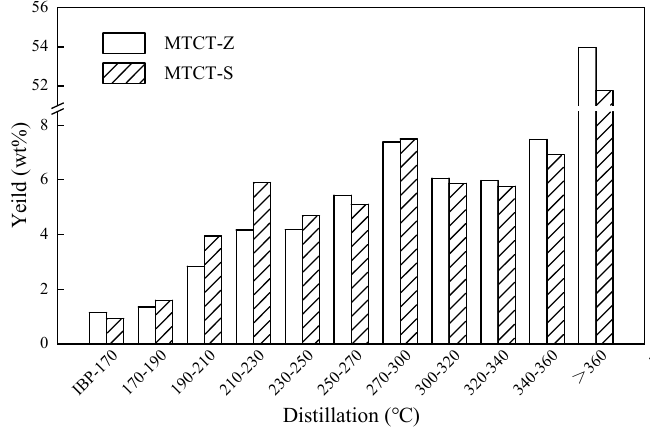
Figure 1. Yields of the distillates.